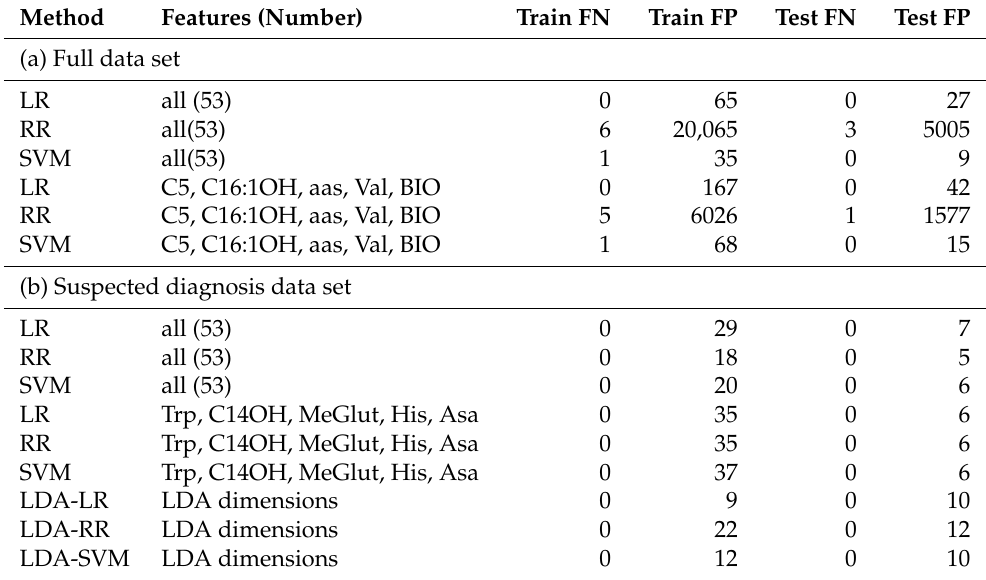
Table 3. Evaluation results of ML methods on (a) the full data set and (b) the suspected diagnosis data set. Methods are applied to all 53 features, 5 features selected with ANOVA, or LDA dimensions. The methods were evaluated by false negatives (FN) and false positives (FP) on the training and test